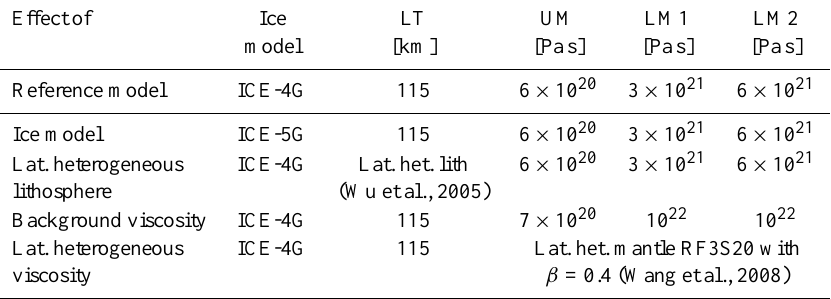
Table 1. Model parameters for the reference model and other models for sensitivity tests. LT: lithospheric thickness; UM: upper-mantle viscosity (above 670km depth); LM1: shallow lower-mantle viscosity (670–1171km depth); LM2: deep lower-mantle viscosity (1171km to core-mantle